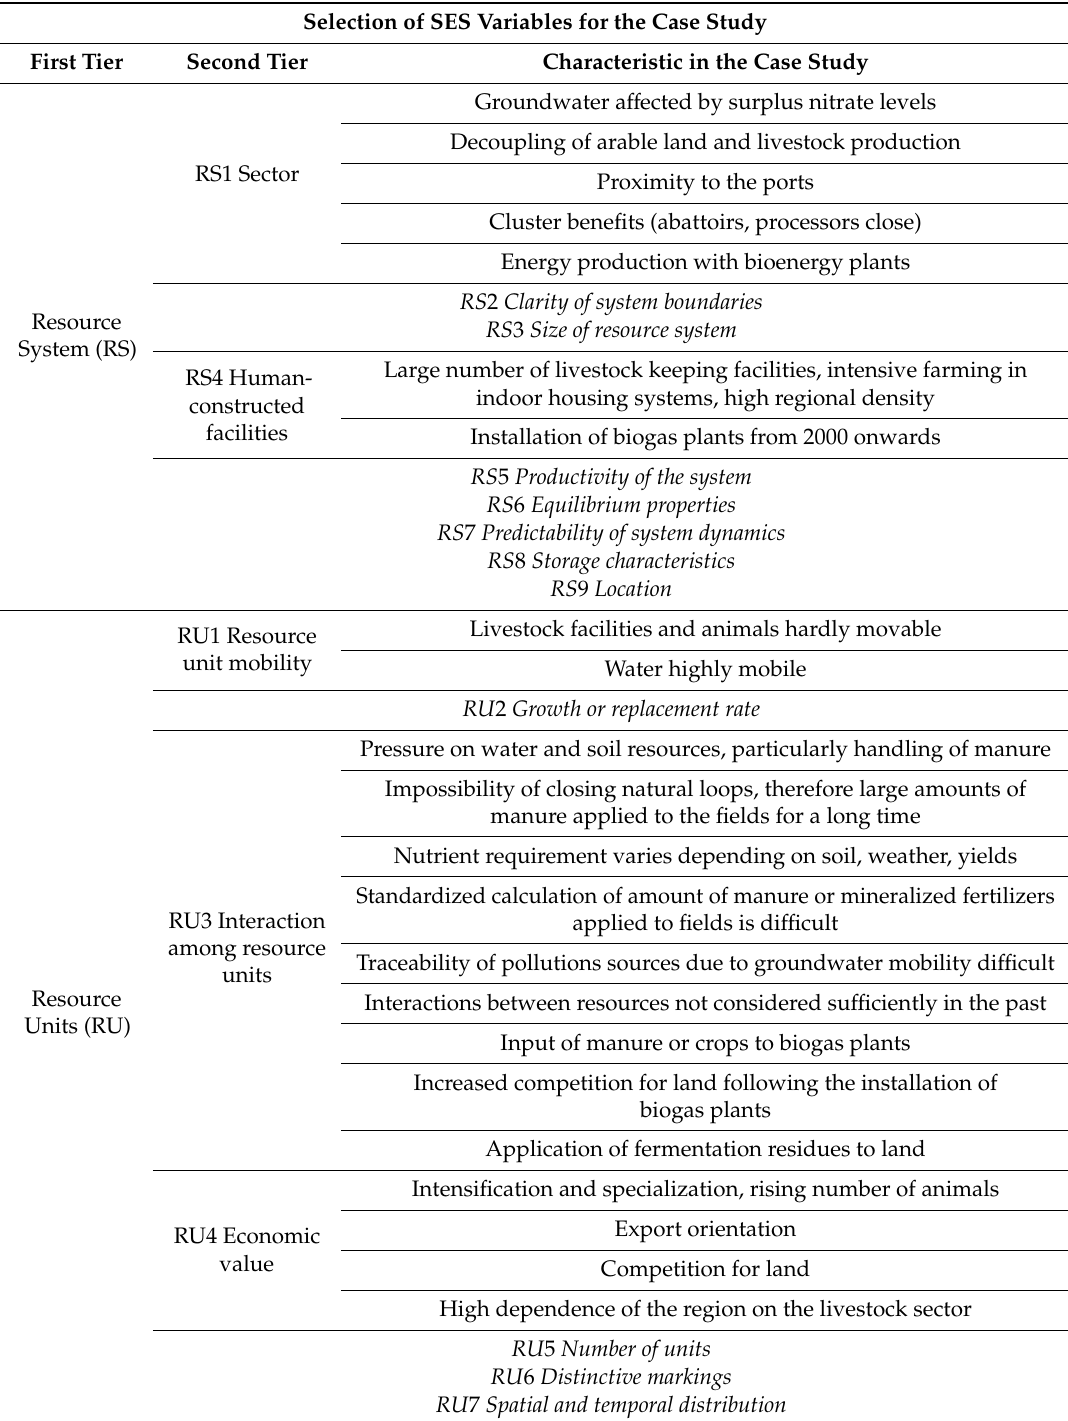
Table 1. Social ecological systems framework (SES) variables selected for the empirical